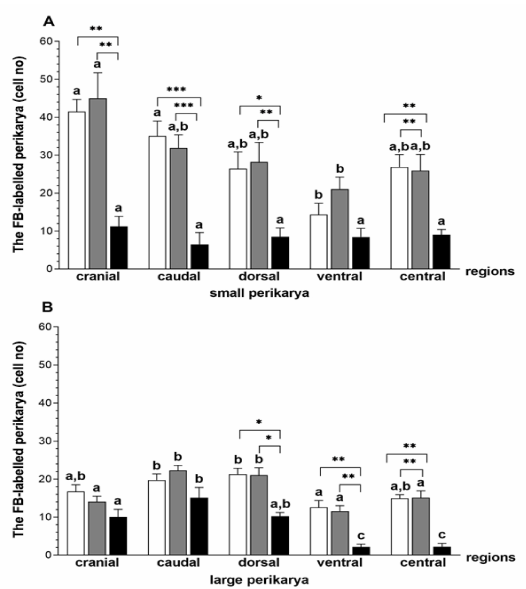
Figure 1. Small ( A ) and large ( B ) perikaryal cell count (mean ± standard error of the mean (SEM)) in the di ff erent regions of the caudal mesenteric ganglion (CaMG) projecting to the uterus of gilts from the control (CON) (white bars), saline (SAL) (grey bars) and E. coli (black bars) groups. Di ff erent letters (a, b, c) show di ff erences ( p < 0.05–0.001) among the particular regions within the CON, SAL and E. coli groups; * p < 0.05, ** p < 0.01 and *** p < 0.001 show di ff erences between all groups in the same ganglion